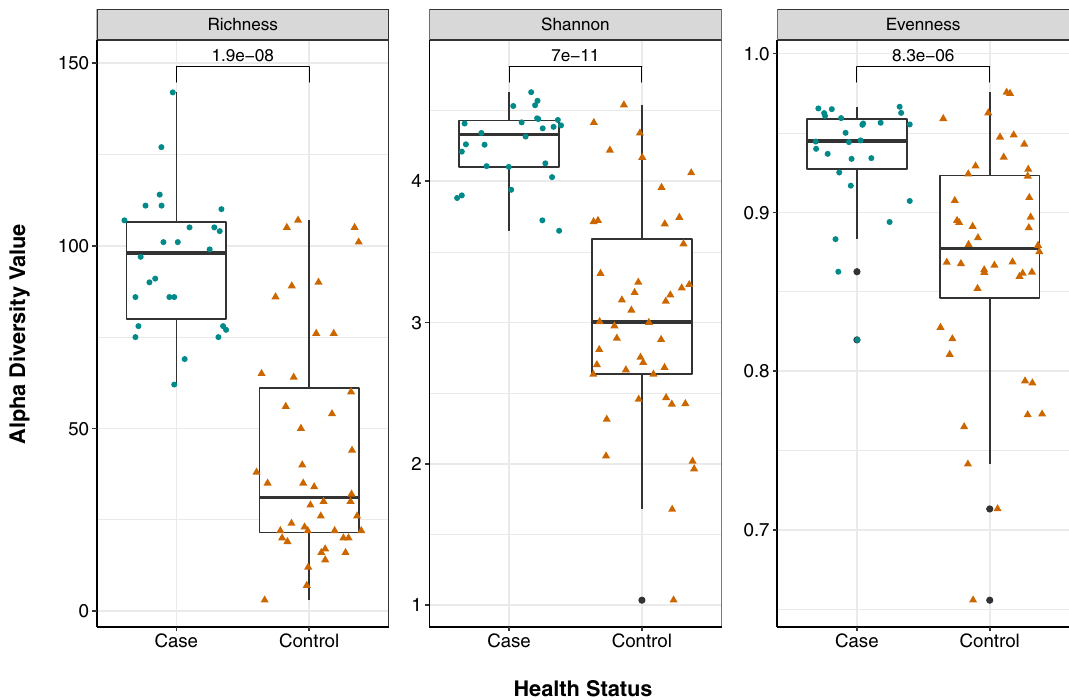
Figure 1. Resistomes in cases are more diverse than resistomes of controls. Three measures of alpha diversity (Richness, Shannon diversity, and Pielou’s Evenness) are shown stratified by health status. The median of each measure is indicated by the thick black bar in each box and the first and third quartiles are represented by the bottom and top of the box, respectively; points (circles and triangles) show variation within each sample type. Outlying points within each group are indicated by the black dots associated with each boxplot. P-values were calculated using the Wilcoxon rank-sum test and are shown above the comparison bar within each plot.